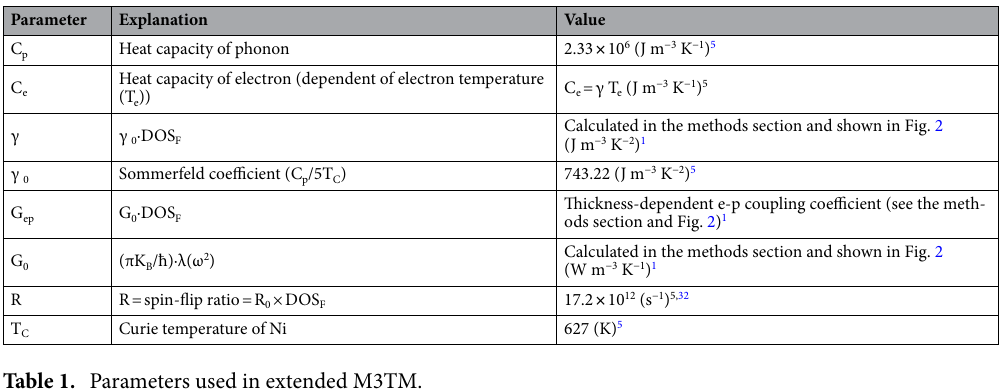
Table 1. Parameters used in extended